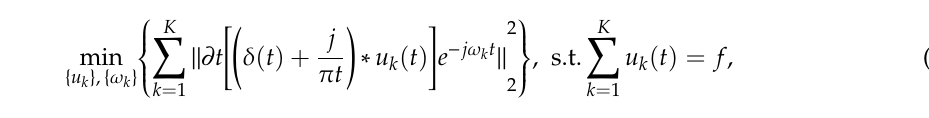
Figure 2. Mallat’s discrete wavelet transform ( DWT) algorithm for three-level decomposition [73].